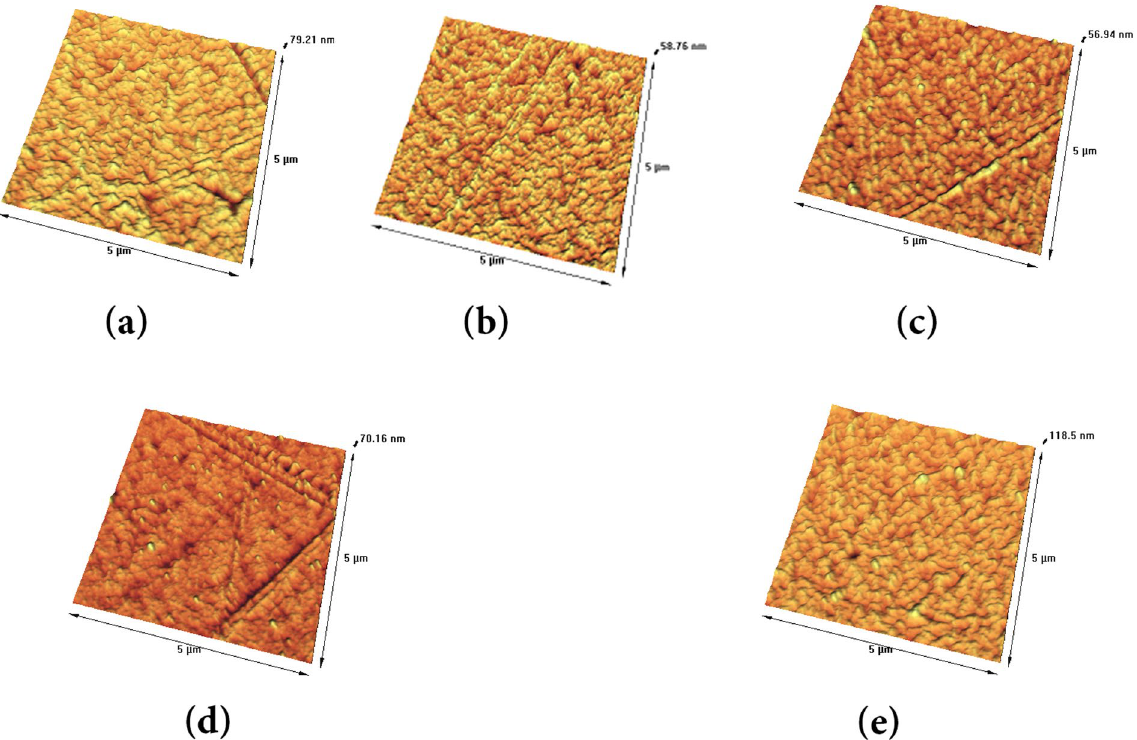
Figure 9. Tree-dimensional AFM images of the plasma-polymers in various ( a ) R = 1, P = 20 (w) ( b ) R = 2, P = 20 (w) ( c ) R = 3, P = 20 (w) ( d ) R = 1, P = 10 (w) ( e ) R = 1, P = 30 (w).